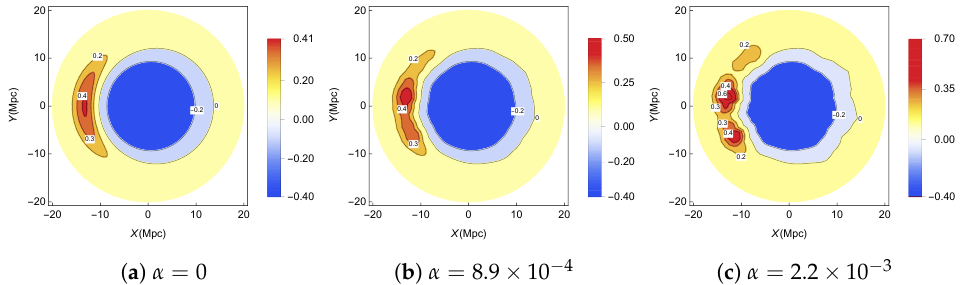
Figure 3. Density contrast in the equatorial plane at the present cosmic time. The case α = 0 corresponds to an exact Szekeres model; then, the Szekeres pancake-shaped overdensity splits into three structures. The coordinates are defined as X = A ( t 0 , z ) z cos φ and Y = A ( t 0 , z ) z sin φ .